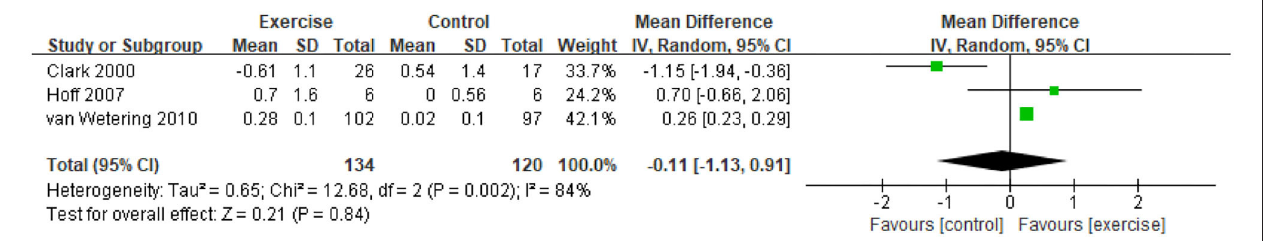
FIGURE 2 | Pooled effect of exercise on BMI in patients with COPD. BMI, body mass index (kg/m 2 ); CI, confidence interval; COPD, chronic obstructive pulmonary disease; SD, standard